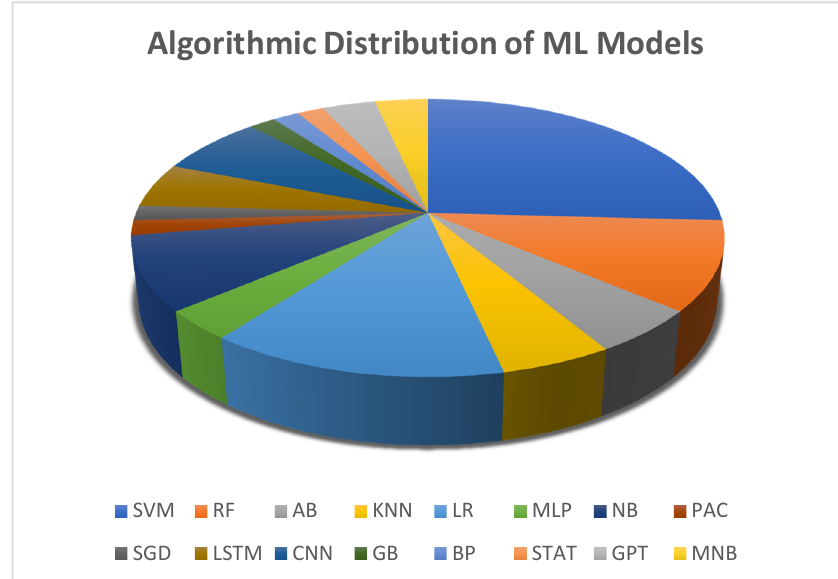
Figure 4. Distribution of classification algorithms on selected studies.